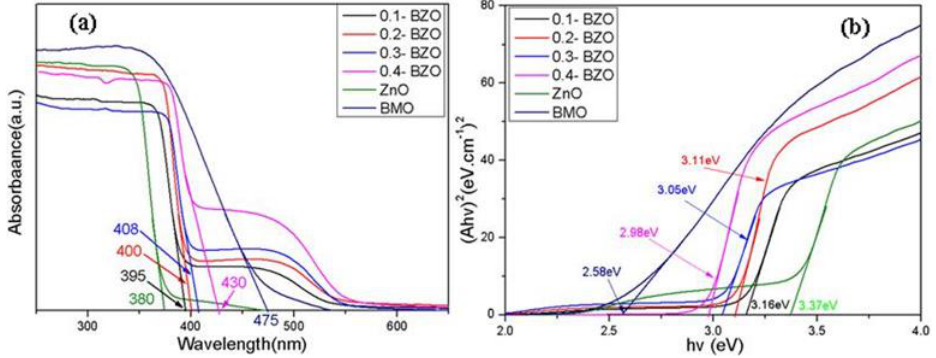
Figure 7. ( a ) The UV – Vis DRS of BMO, ZnO, and X-BZO, and ( b ) variation of (αhν) n/2 versus photon energy (hν).